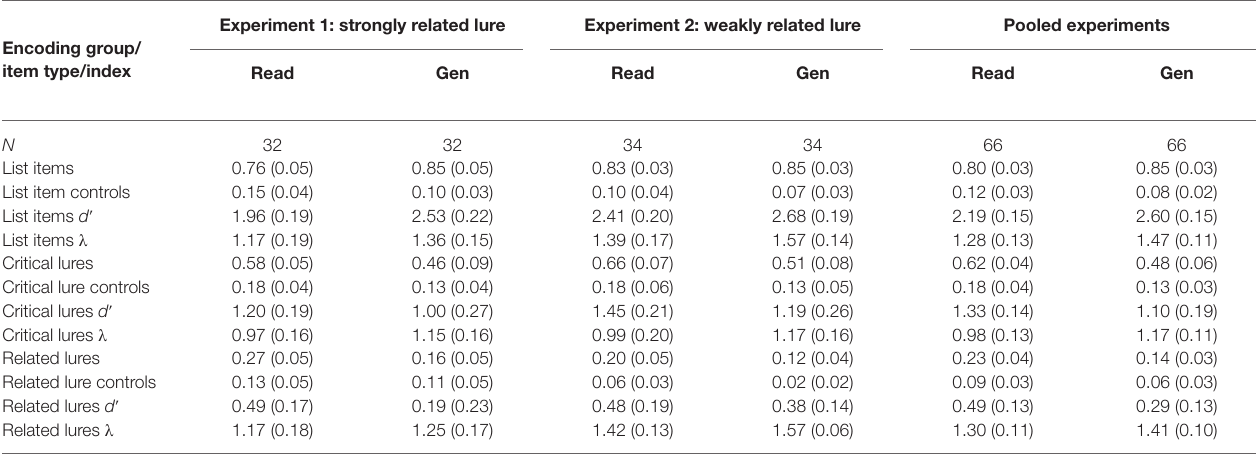
TABLE 2 | Mean (95% CI) proportion of “Old” responses and signal-detection indices as a function of item type/index and group/list type for test lists with strongly related lures (Experiment 1), weakly related lures (Experiment 2), and means pooled across experiments. Experiment 1: strongly related lure Experiment 2: weakly related lure Pooled experiments Encoding